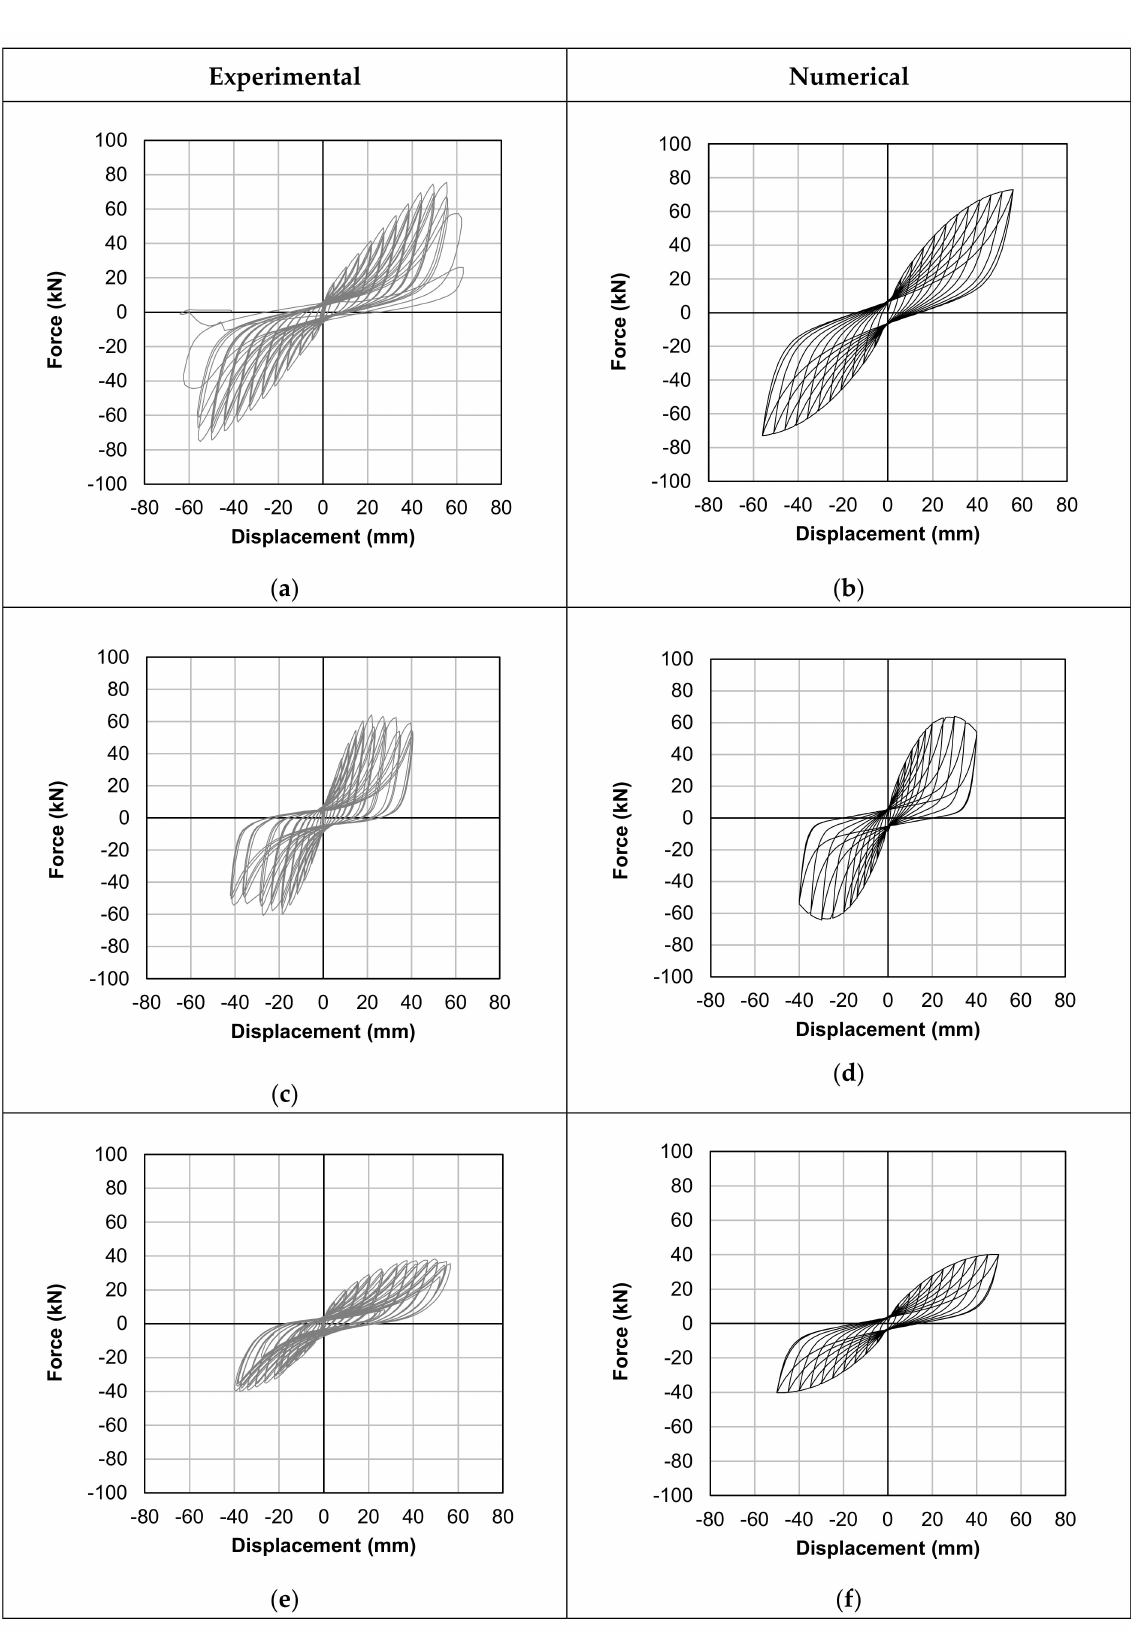
Figure 2. Validation of the macro-element modeling strategy for timber diaphragms with the user-supplied subroutine based on the formulated analytical model [38,41]: ( a ) experimental and ( b ) numerical responses of a sample tested parallel to the joists; ( c ) experimental and ( d ) numerical responses of a sample tested perpendicular to the joists; ( e ) experimental and ( f ) numerical responses of a sample representing a roof